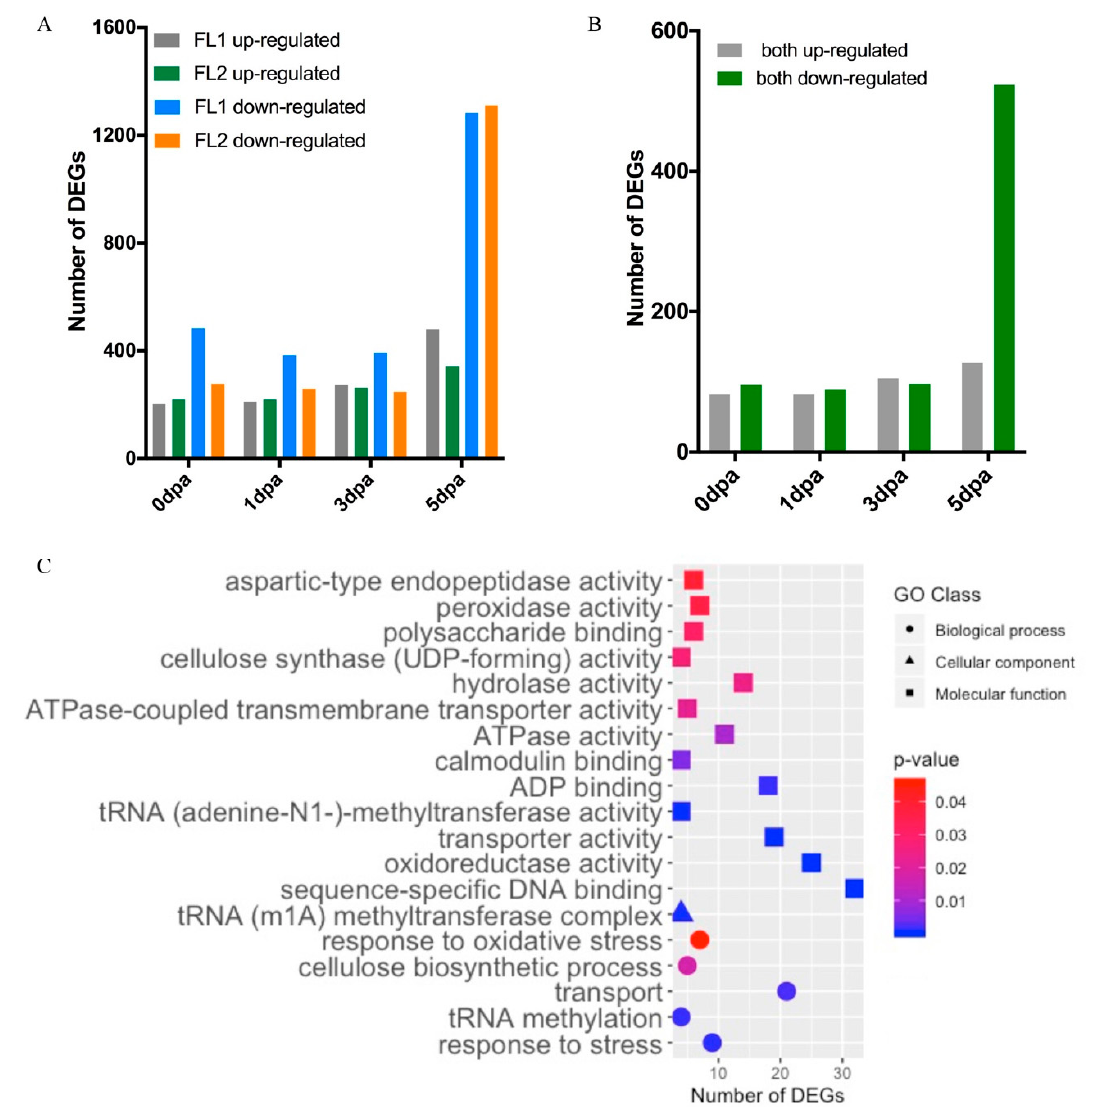
Figure 8. Transcriptome analysis results of the fuzzless accessions (FL). ( A ) Number of DEGs identified in pairwise comparison between FL1 and Normal and FL2 and Normal. ( B ) Number of DEGs that were up- or down-regulated in both FL1 and FL2. ( C ) Enriched GO terms based on DEGs up- and down-regulated in both FL1 and FL2.